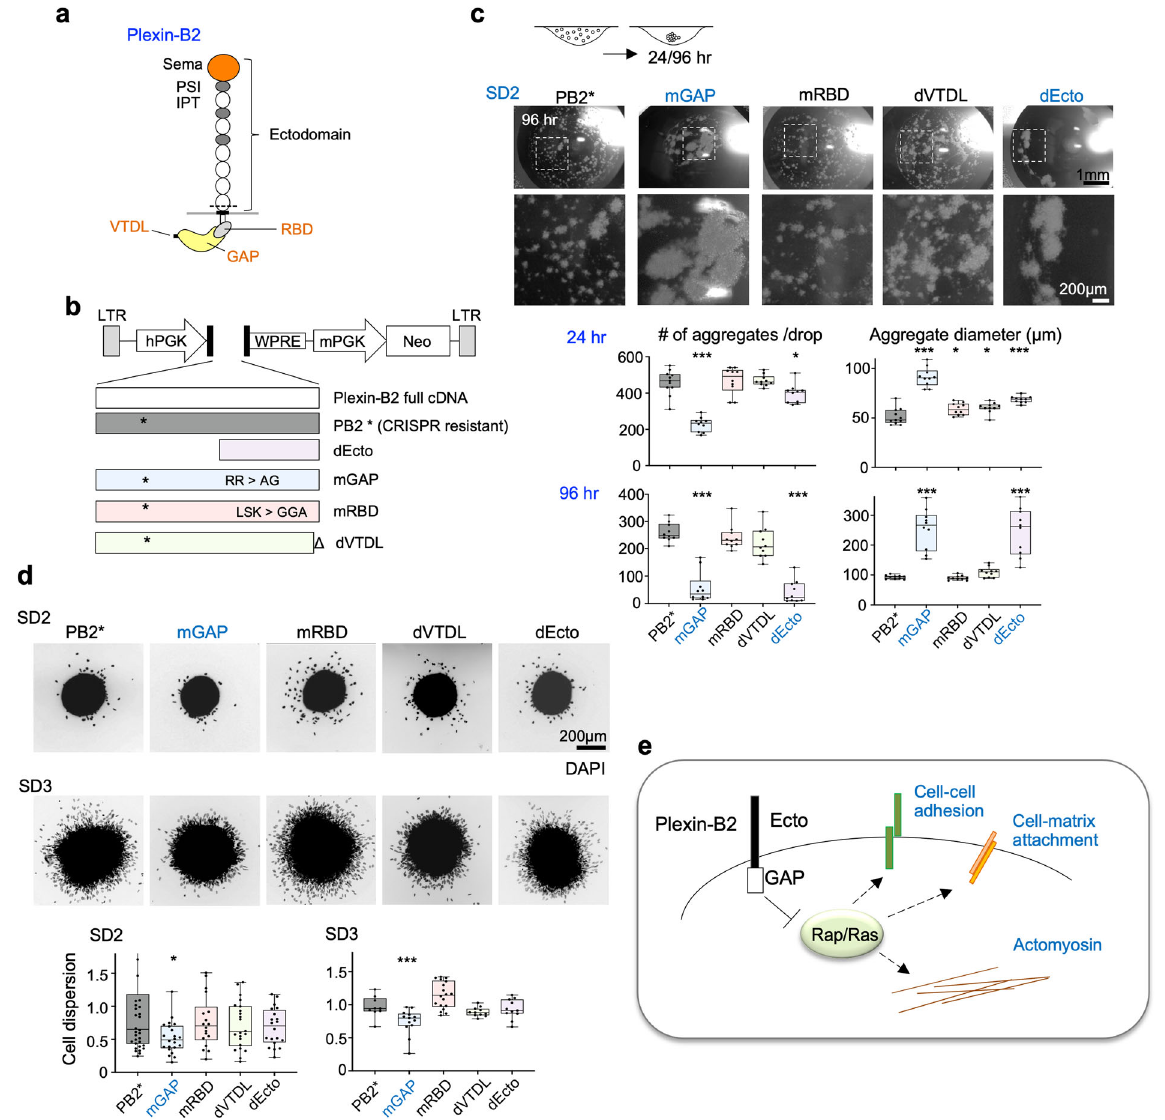
Fig. 7 Plexin-B2 signaling engages the Ras-GAP domain. a Cartoon of Plexin-B2 domain structure. Cell membrane shown as a gray bar; dashed line indicates proteolytic cleavage into α and β chains. Sema, Sema domain; PSI, plexin-semaphorin-integrin domain; IPT, Ig-like fold shared by plexins and transcription factors; RBD, Rho-binding domain; GAP, GTPase activating protein; VTDL, PDZ-domain binding site formed by four C-terminal amino acids for docking of PDZ-Rho-GEF or LARG proteins. b Diagrams of lentiviral vectors encoding cDNA of wild-type or signaling mutants of Plexin-B2. PB2* is CRISPR- resistant cDNA, due to synonymous mutations (X) at sgRNA target site. dEcto lacks extracellular domain, mGAP has mutated GTPase activation domain, mRBD has mutated Rho-binding domain, and dVTDL has deleted PDZ-binding motif. c Cell aggregation assay in hanging drops used for Plexin-B2 (PB2) rescue experiments. Photos and enlargements show aggregates formed from GSCs with the indicated Plexin-B2 mutations in hanging drops after 96 h. Quanti fi cations of aggregate numbers and sizes in hanging drops at 24 or 96 h are shown below. The mGAP and dEcto Plexin-B2 mutants failed to rescue the KO phenotype (marked as blue). n = 5 – 11 drops per group; one-way ANOVA with Dunnett ’ s multiple comparison test of each group against SD2-Ctrl; * P < 0.05, ***0.001. d Left, representative micrographs of cell dispersion assay with GSCs expressing mutant Plexin-B2 rescue constructs. Dispersed cells from aggregates were visualized at 4 h with DAPI nuclear stain. Bottom, quanti fi cations show the number of nuclei detached from spheres normalized to mean in the control condition. The PB2 mGAP mutant failed to rescue the KO phenotype (marked as blue). Box plots and whiskers indicate quartiles, center lines indicate median. n = 18 – 34 spheres per group; one-way ANOVA with Dunnett ’ s multiple comparison test of each group against control; * P < 0.05, *** P < 0.001. e Model depicting Plexin-B2 signaling through Ras-GAP domain to affect cell biomechanics during GBM